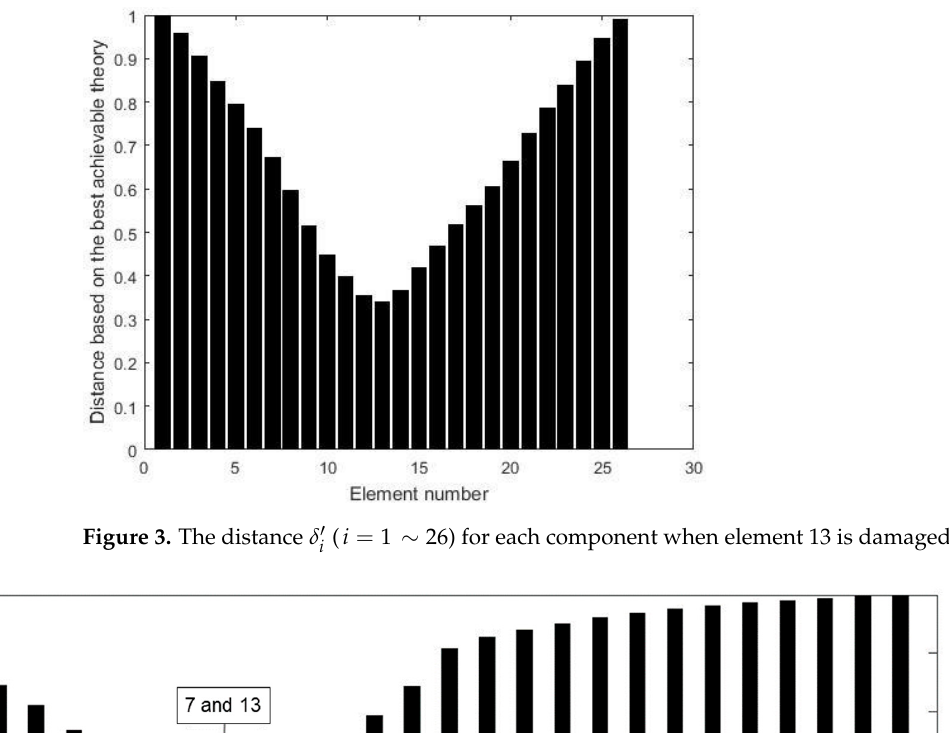
'  ( 26 ~ 1 = i ) for each element when element 13 is damaged (no noise). Figure 2. The distance i